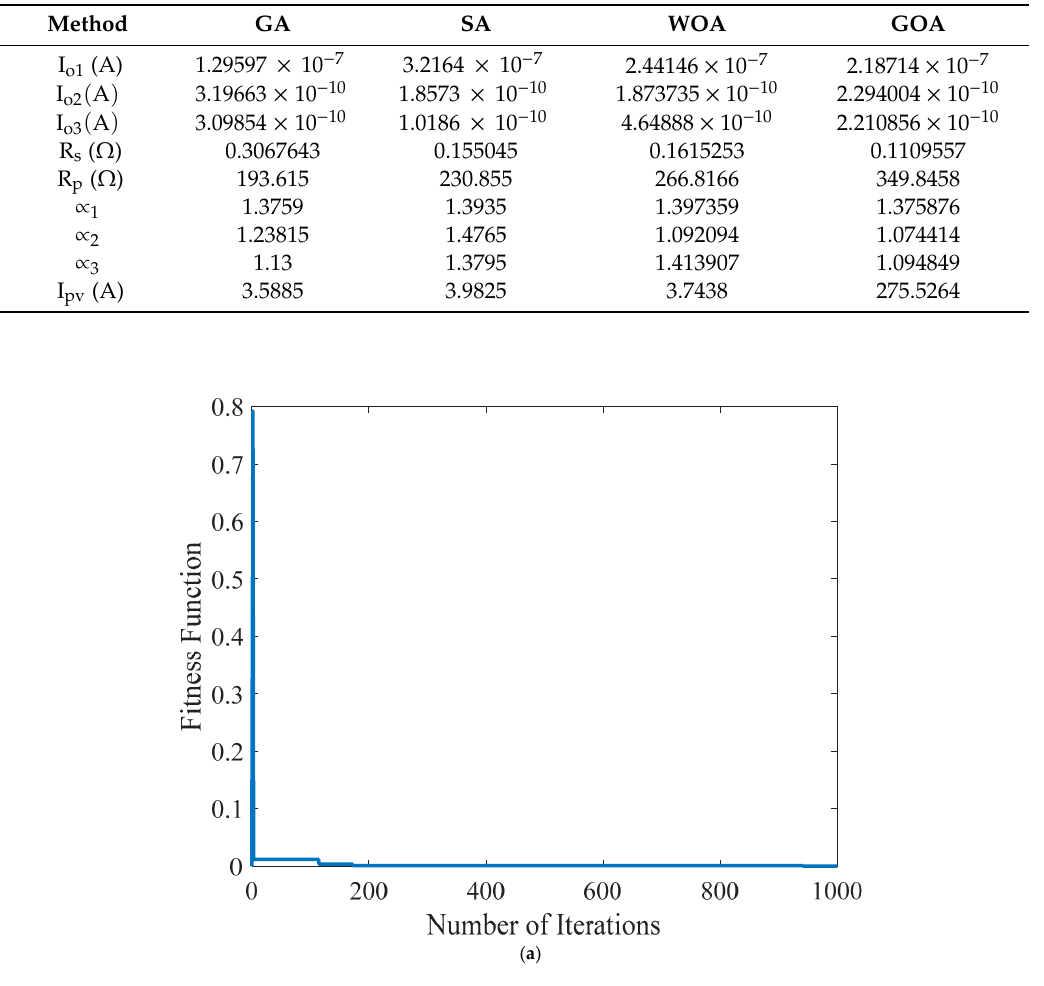
Table 3. Comparison among Optimum models for MSX-60.